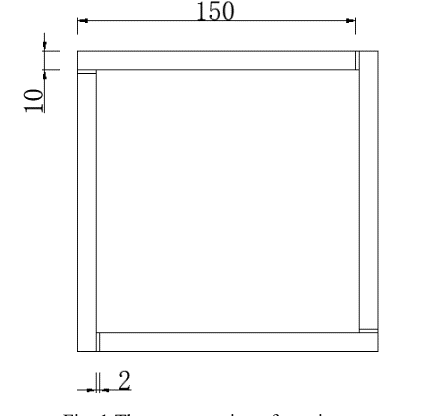
Fig. 1 The cross-section of specimens.